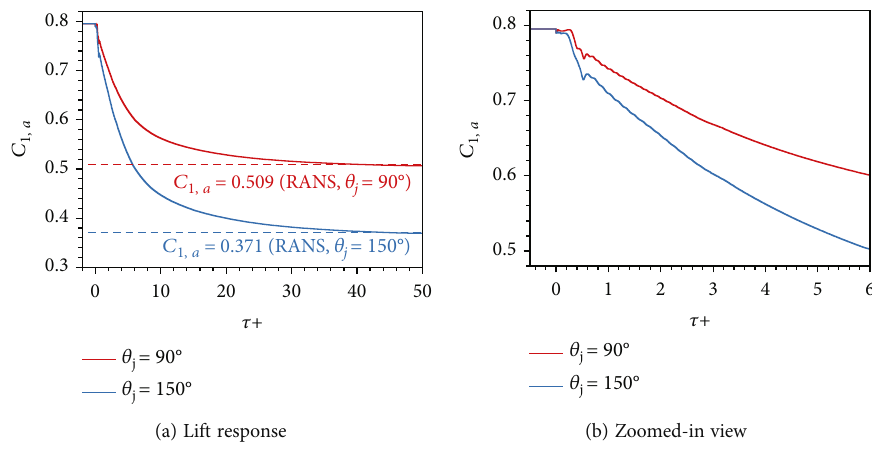
= 0 : 729 , α = 3 ° , and C ∞